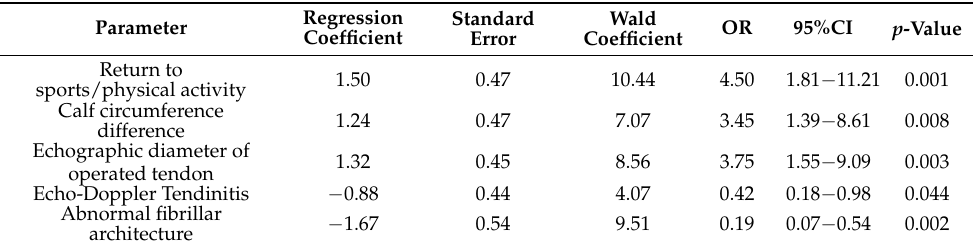
Table 4. Multivariate logistic regression analysis of co-variates associated with Tenolig surgical